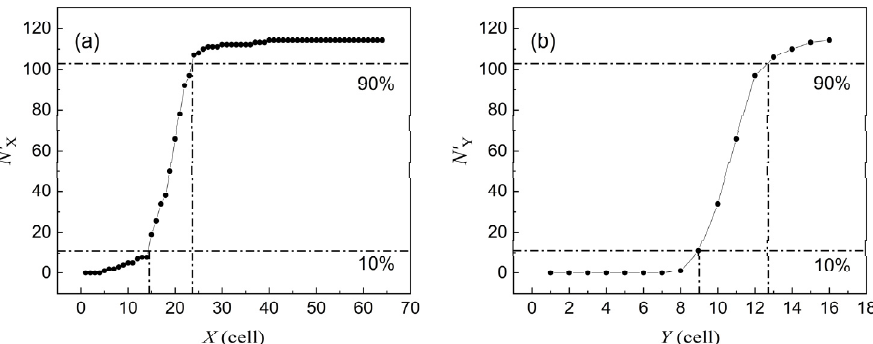
Figure 4. Plot of upset counts in the X ( a ) and Y ( b ) projection from two-dimensional distribution.